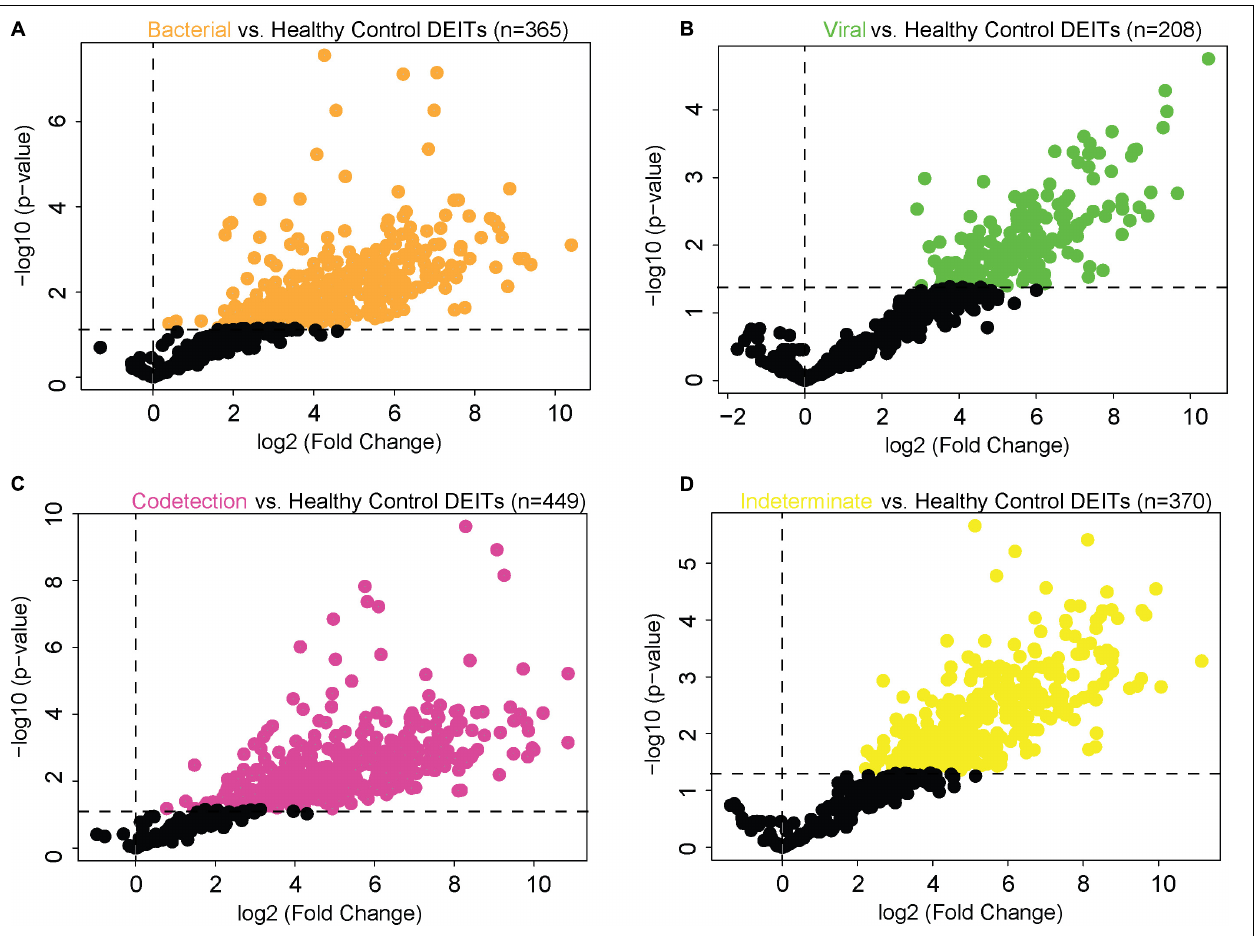
FIGURE 2 | Differentially expressed immune genes in nasopharyngeal aspirates of children with ARI. “Volcano plots” of statistical significance against fold change between NPAs harboring microbial load [classified as bacterial, orange (A) ; viral, green (B) ; codetection, pink (C) ; and indeterminate, yellow (D) ] and NPAs from healthy controls, demonstrating the number of differentially expressed immune